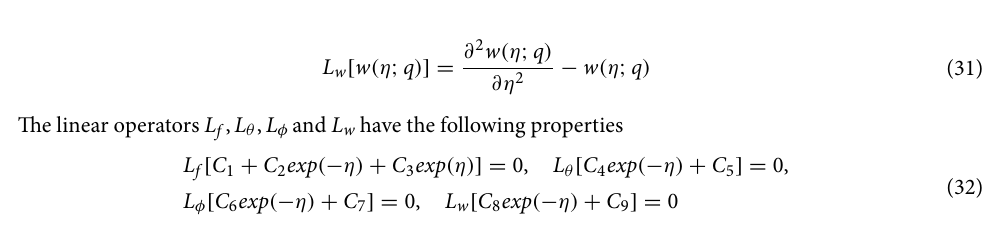
Figure 1. ( a ) Effect of K 1 = K 2 on velocity profile when δ t = δ n = 0.1 . ( b ) Effect of K 1 = K 2 on velocity profile when δ t = δ n = 0.1